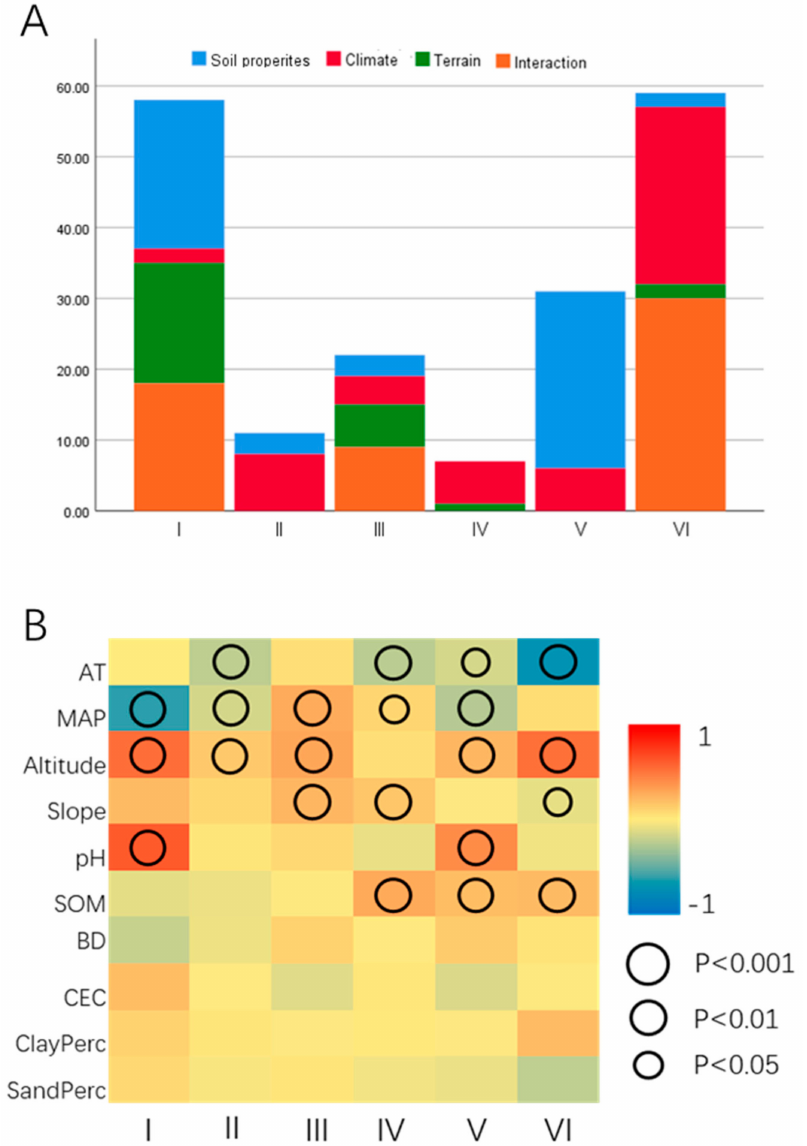
Figure 7. Analysis of bacterial abundance in partitions. ( A ) Variation partition of partitions, which includes soil properties, climate, terrain, and interaction. ( B ) Pearson coefficient of partitions; colors indicate the value of the Pearson coefficient and the circles indicate the confidence level. I, the black and dark brown soil areas in the low foothills of the Xiaoxing’an Mountains. II, the brown and black soil area in the Liaohe Plain. III, the white mud soil area in the Sanjiang Plain. IV, the black soil calcareous region of Songnen Plain. V, the western semi-arid area. VI, the dark brown soil area in low hilly area of Changbai